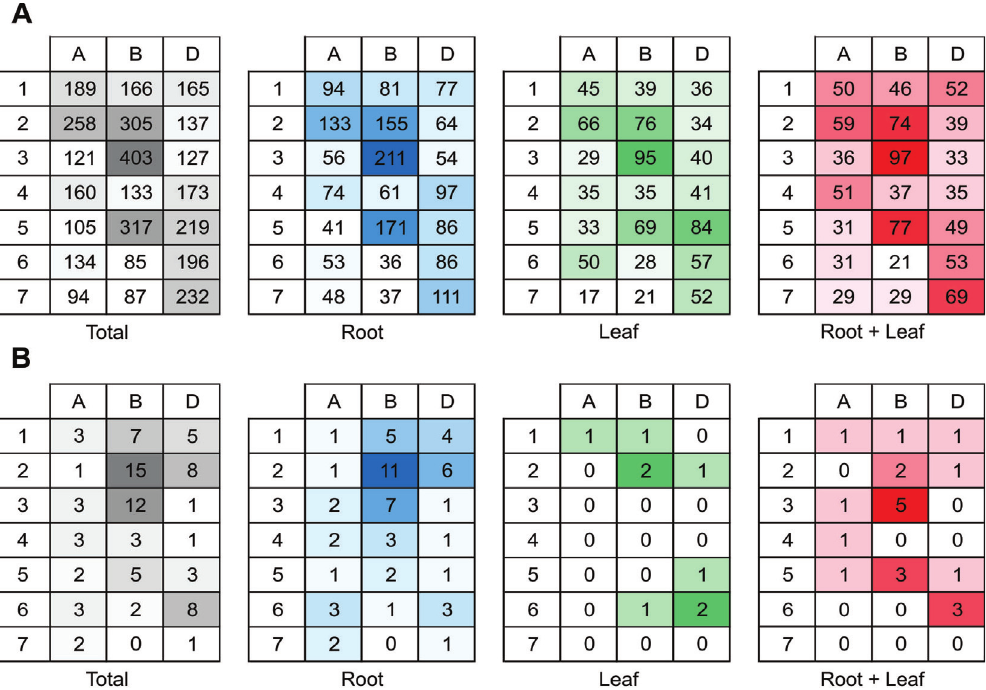
Figure 8 - Heat map showing the localization of the candidate genes associated to drought response in the wheat cultivar MGS1 Aliança. Hit distribution by tissue was obtained by BLAST against the genome of Triticum aestivum cv. Chinese spring at an E-value cutoff 1e-100. Numbers represent the hit dis- tribution for each chromosome. “Total” means hit distribution of all sequences. “Root” means hit distribution of transcripts specifically expressed in roots. “Leaf” means hit distribution of transcripts specifically expressed in leaf. “Root + Leaf” means hit distribution of transcripts expressed in common between root and leaf. Darker colors mean higher number of reads. (A) All the candidate genes. (B) Only the candidate genes classified as